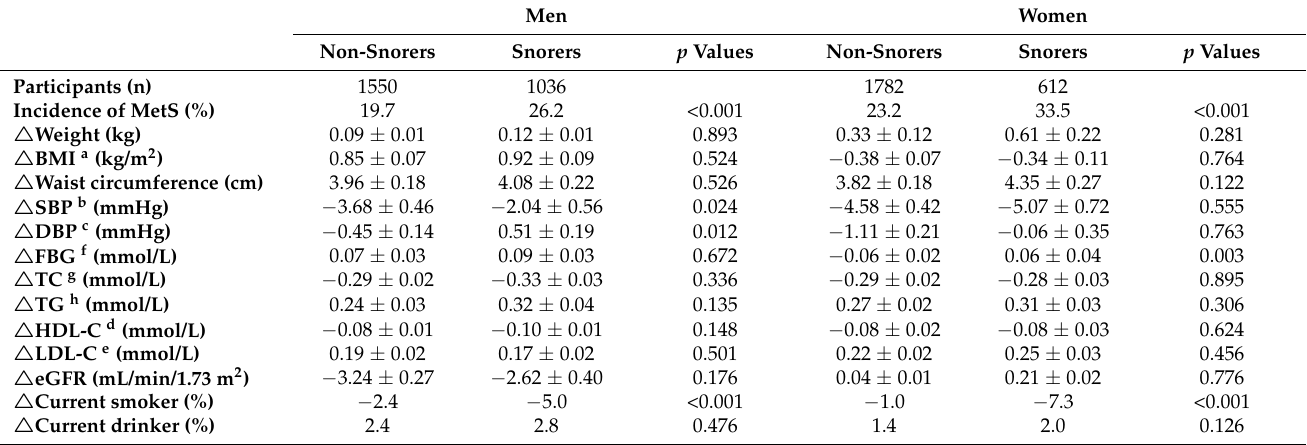
All values in parentheses represent the standard deviation. a Body mass index, b systolic blood pressure, c diastolic